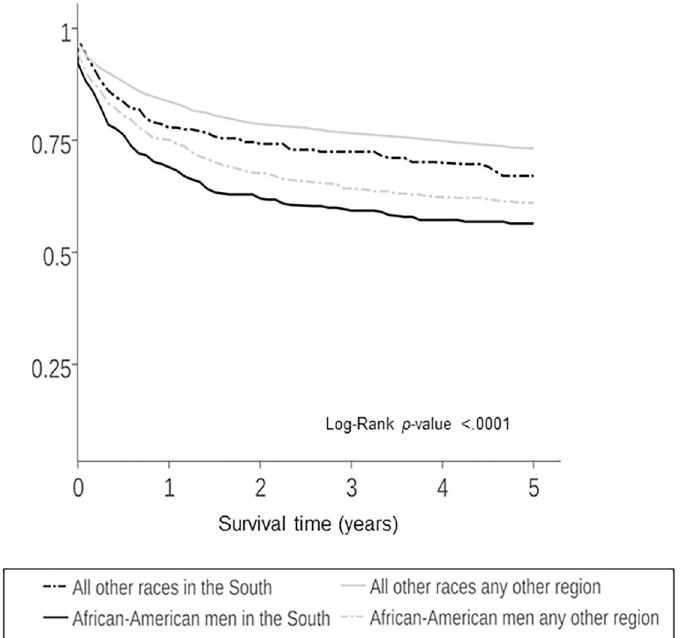
Fig 6. KS survival in the U.S. by Race and Geographic Region, 2000–2013,N = 3,793.